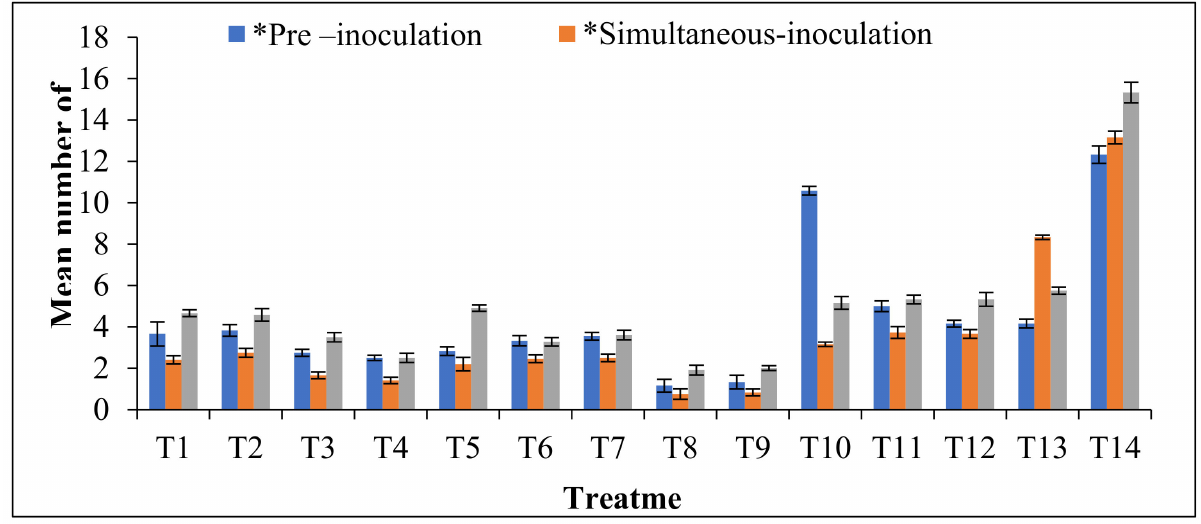
Figure 4. In vitro screening for the antiviral activity of bio-control agents, botanicals, and defense inducers against TSWV on Cowpea (var. Co 7).Note:T1- Bacillus cereus BSC5-0.5% at 10 8 cfu/mL; T2- B. pumilis BSC4 -0.5% at 10 8 cfu/mL; T3- B. licheniformis B12-0.5% at 10 8 cfu/mL; T4- B. velezensis VB7-0.5% at 10 8 cfu/mL; T5- B. subtilis BAG3-0.5% at 10 8 cfu/mL; T6- Pseudomonas fluorescens Pf1-0.5% at 10 8 cfu/mL; T7- Ochrobactrum spp . BSD 5-0.5% at 10 8 cfu/mL; T8- Mirabilis jalapa (MJ)-10%; T9- Harpulia cupan ioides (HC) 10%; T10-Potassium sulphate (K 2 SO 4 )-0.1%; T11-Potassium silicate (K 2 SiO 3 )-0.1%; T12-Potassium thiosulphate (K 2 S 2 O 3 )-0.1%; T13-Chitosan-1%;